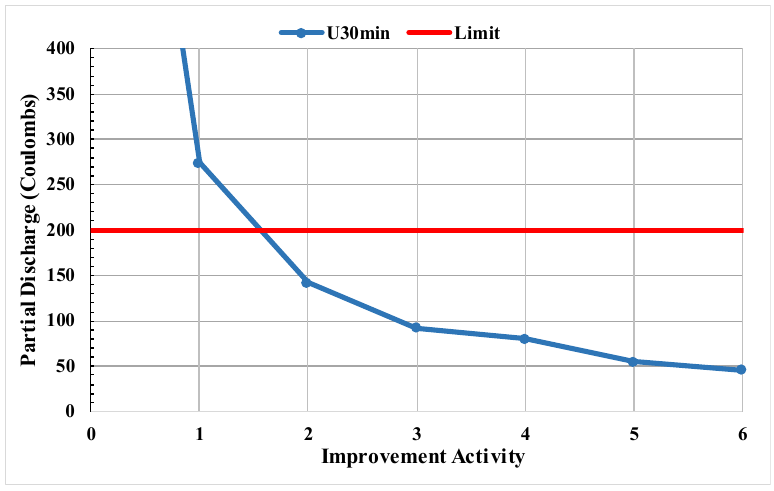
Figure 19. Partial discharge values corresponding to U 30min .